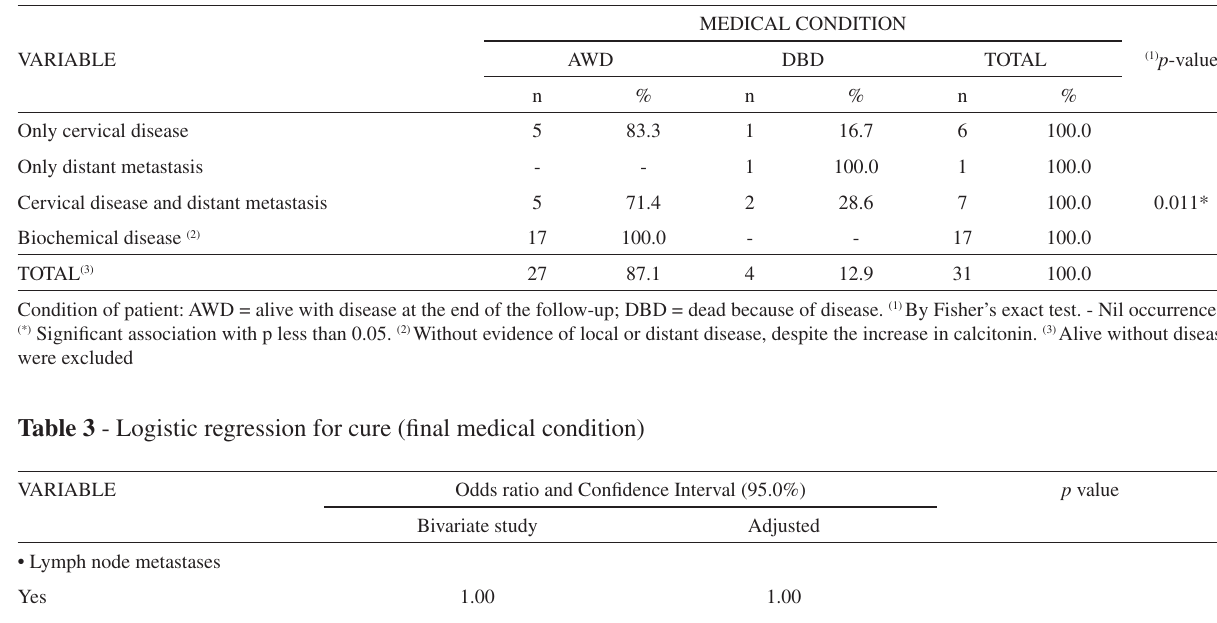
Table 2 - Correlation of final medical condition with progression presentation (patients not cured)